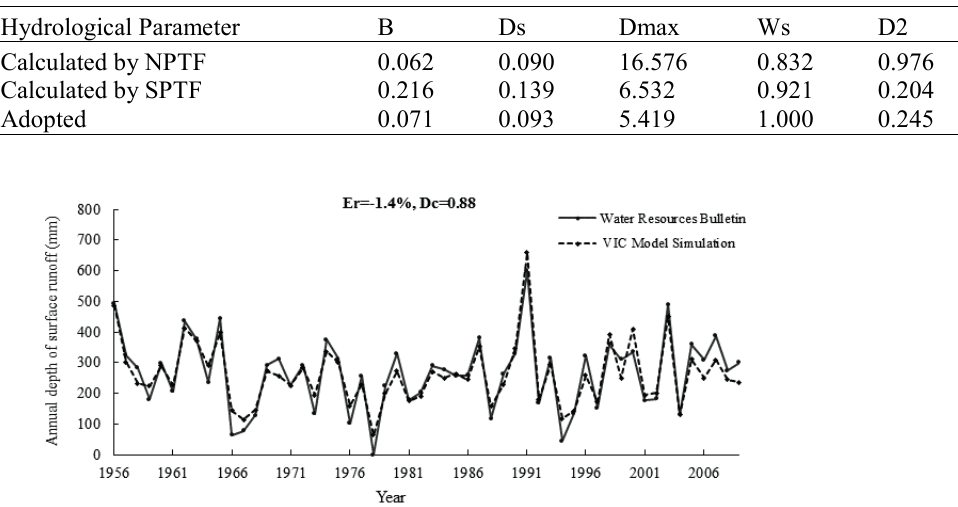
Fig. 2 Comparison of annual runoff simulated by VIC and that published by JWRB for Jiangsu province during